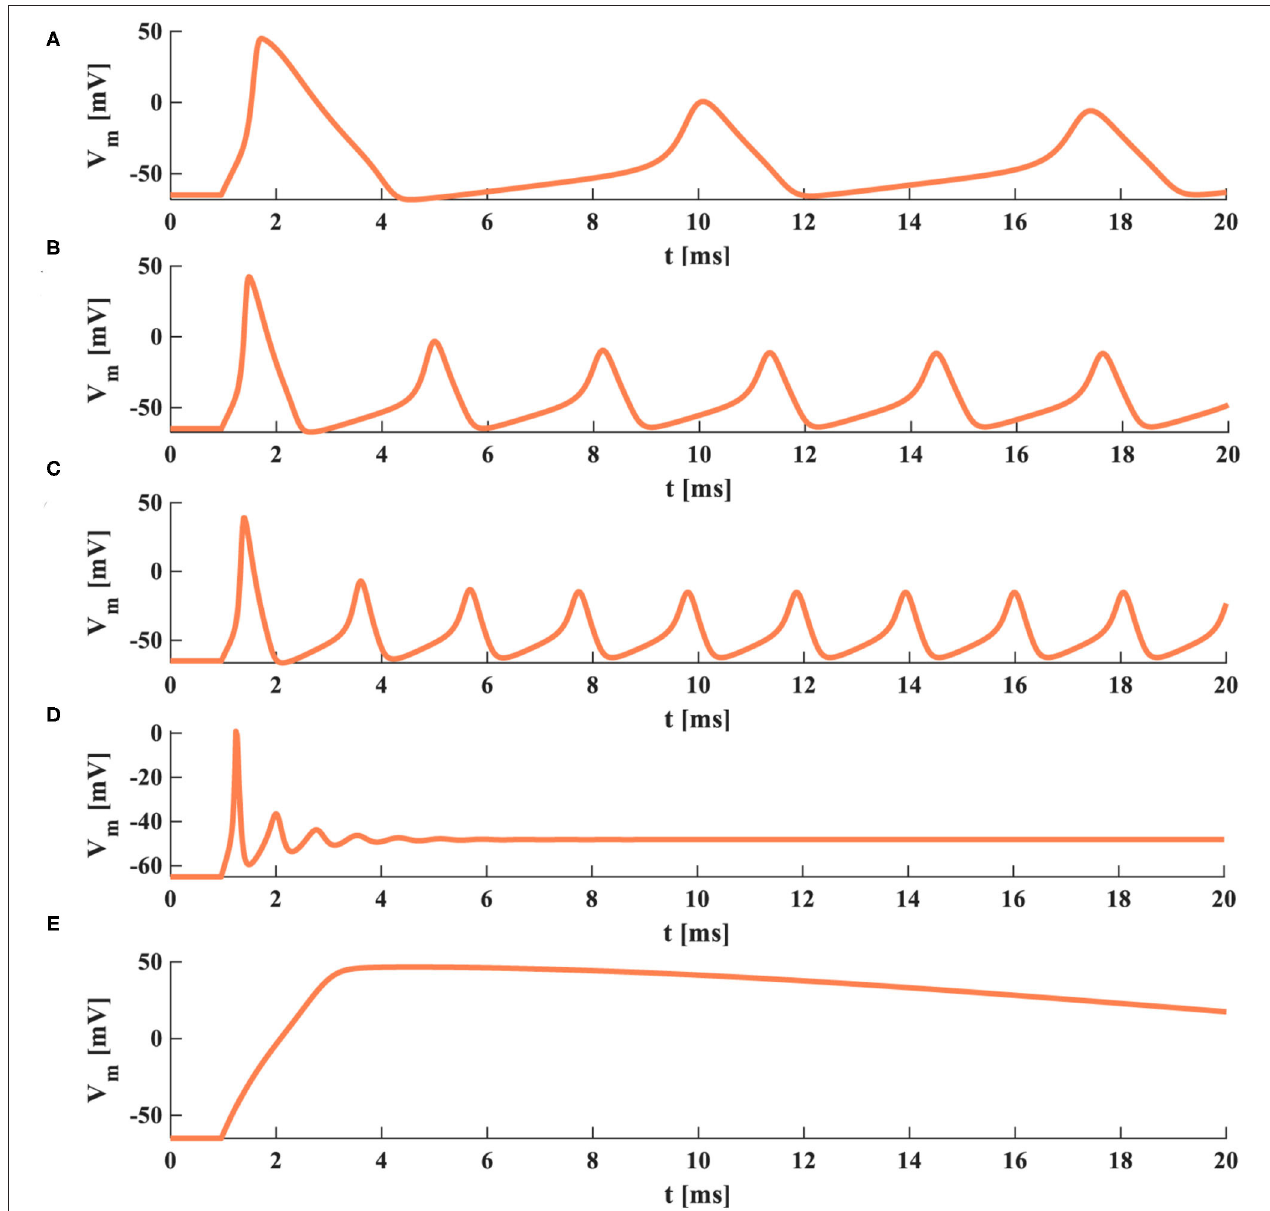
FIGURE 5 | The action potentials under the different temperatures (the external stimulus is 0.08 mAcm − 2 ). (A) The temperature is 6.3 ◦ C . (B) The temperature is 15 ◦ C . (C) The temperature is 20 ◦ C . (D) The temperature is 35 ◦ C . (E) The temperature is − 20 ◦ C .